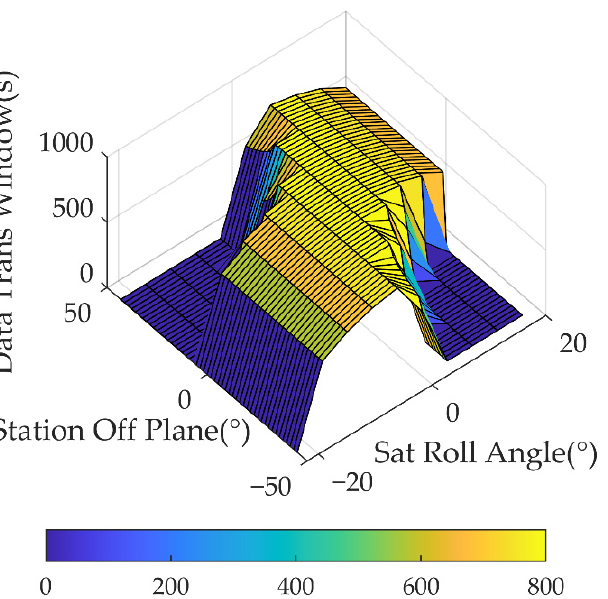
Figure 4. Influence diagram of the satellite attitudes and ground station distribution on the data transmission time.